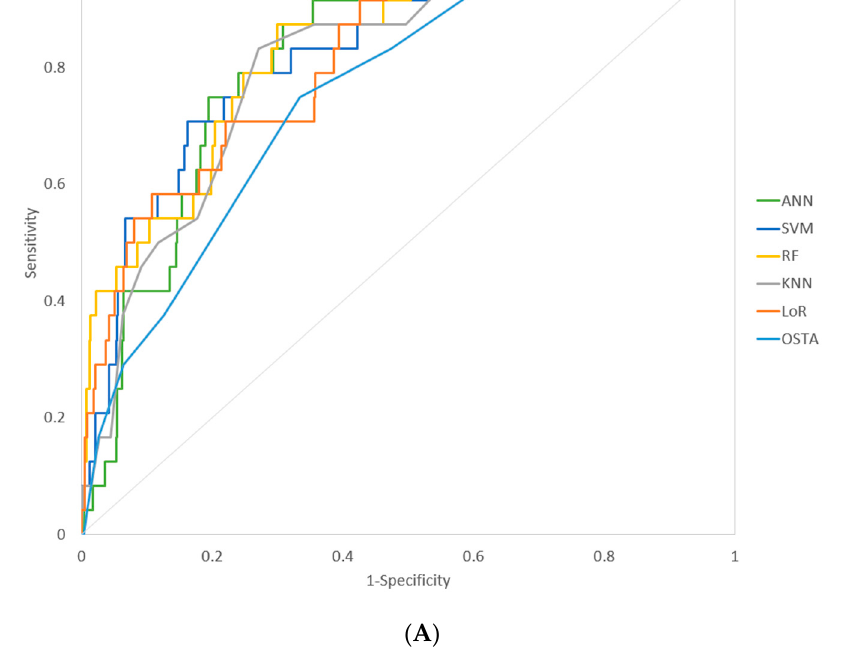
8 of 12 Table 4. Performance of different machine learning models and the OSTA model for prediction of osteoporosis in men and women. Model